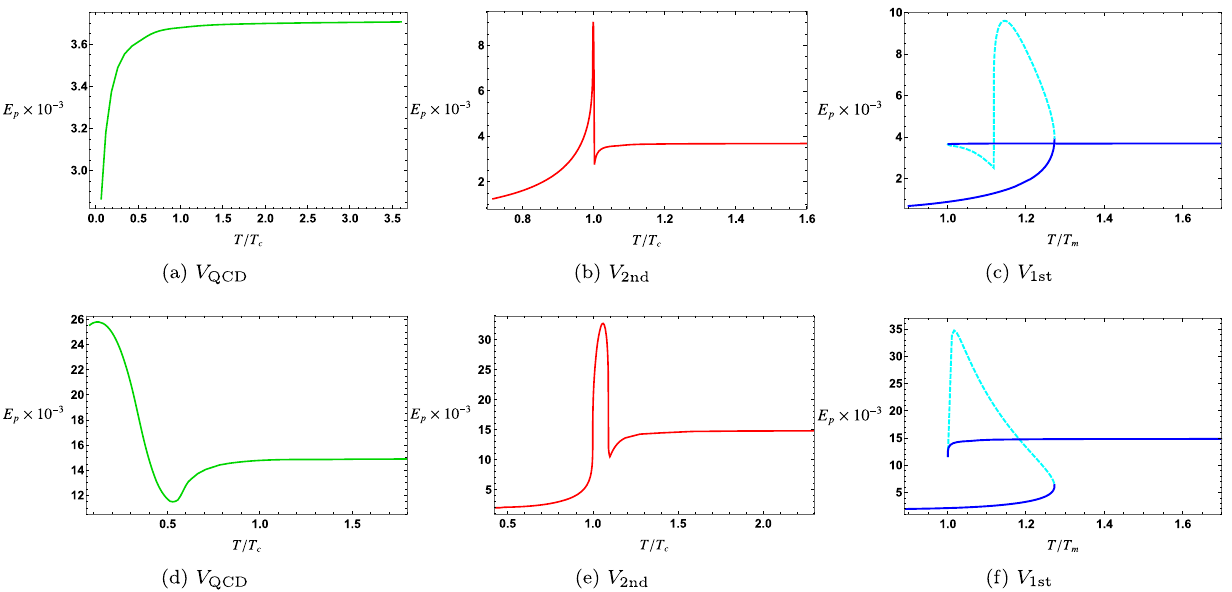
Fig. 9 Top row: The EoP v.s. temperature T for the dilaton poten- tials V QCD (left), V 2nd (middle) and V 1st (right) for fixed l = 0 . 05 and l (cid:3) = 0 . 01. Bottom row: The EoP v.s. temperature T for the dilaton potentials V QCD (left), V 2nd (middle) and V 1st (right) for fixed l = 0 . 05